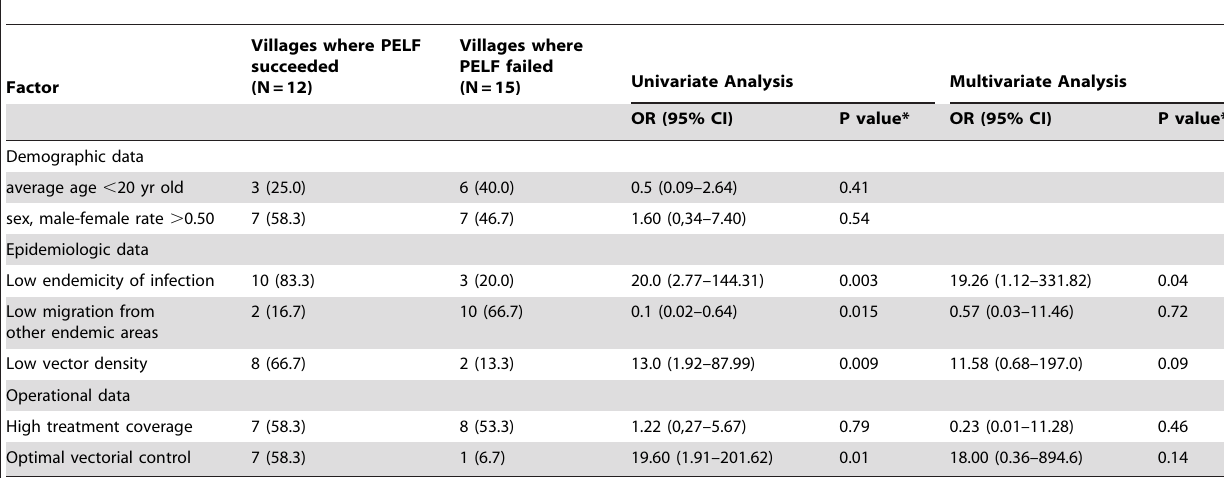
Table 2. Association between characteristics of villages and program related factors and PELF success to control infection prevalence.